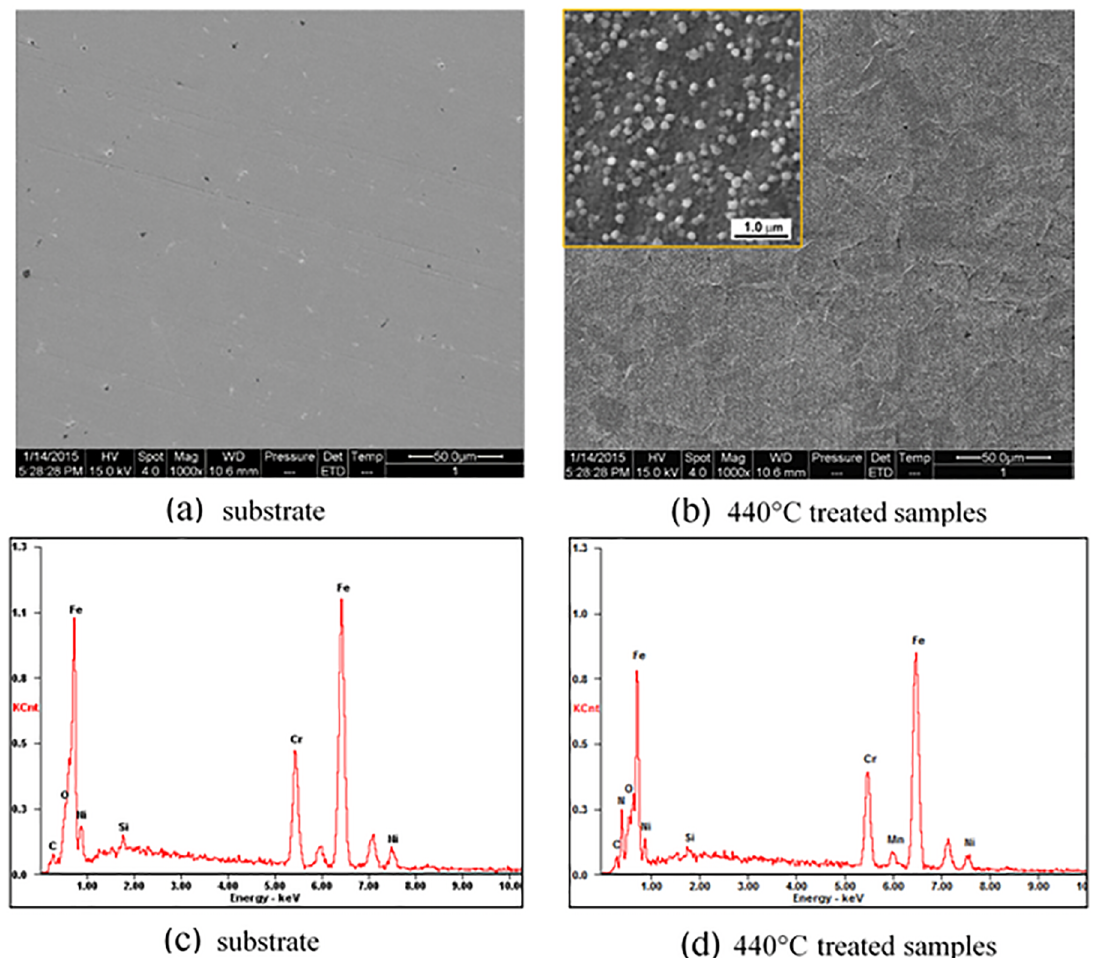
Figure 4 . SEM image from substrate (a) and the 440°C treated samples(b). EDS microanalysis of the substrate (c) and the treated surface